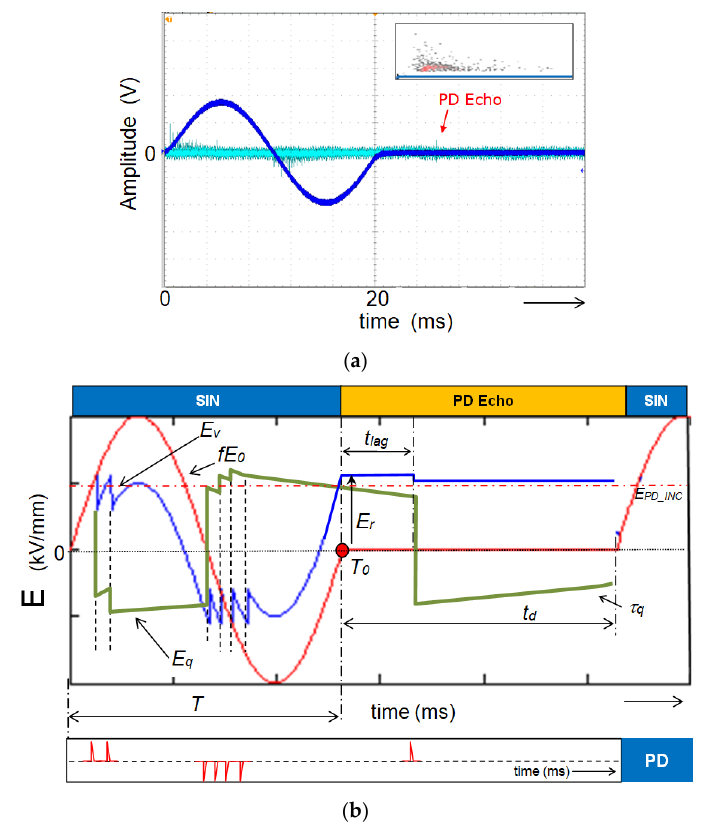
Figure 8. The PD Echo mechanism without a PD pulse, prior to the transition point T 0 . ( a ) an exemplary individual Partial Discharge Echoes (PDE) time-recording; ( b ) electric field waveforms.